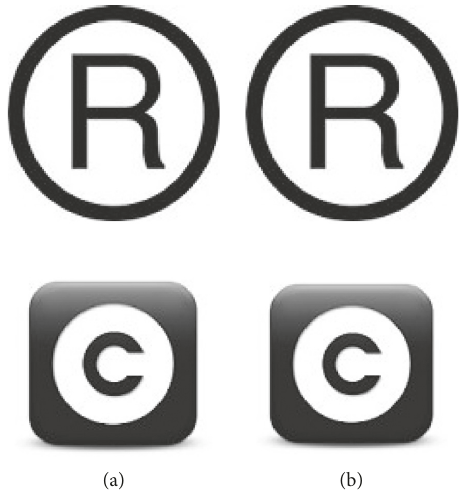
Figure 6: (a) Original message and (b) extracted